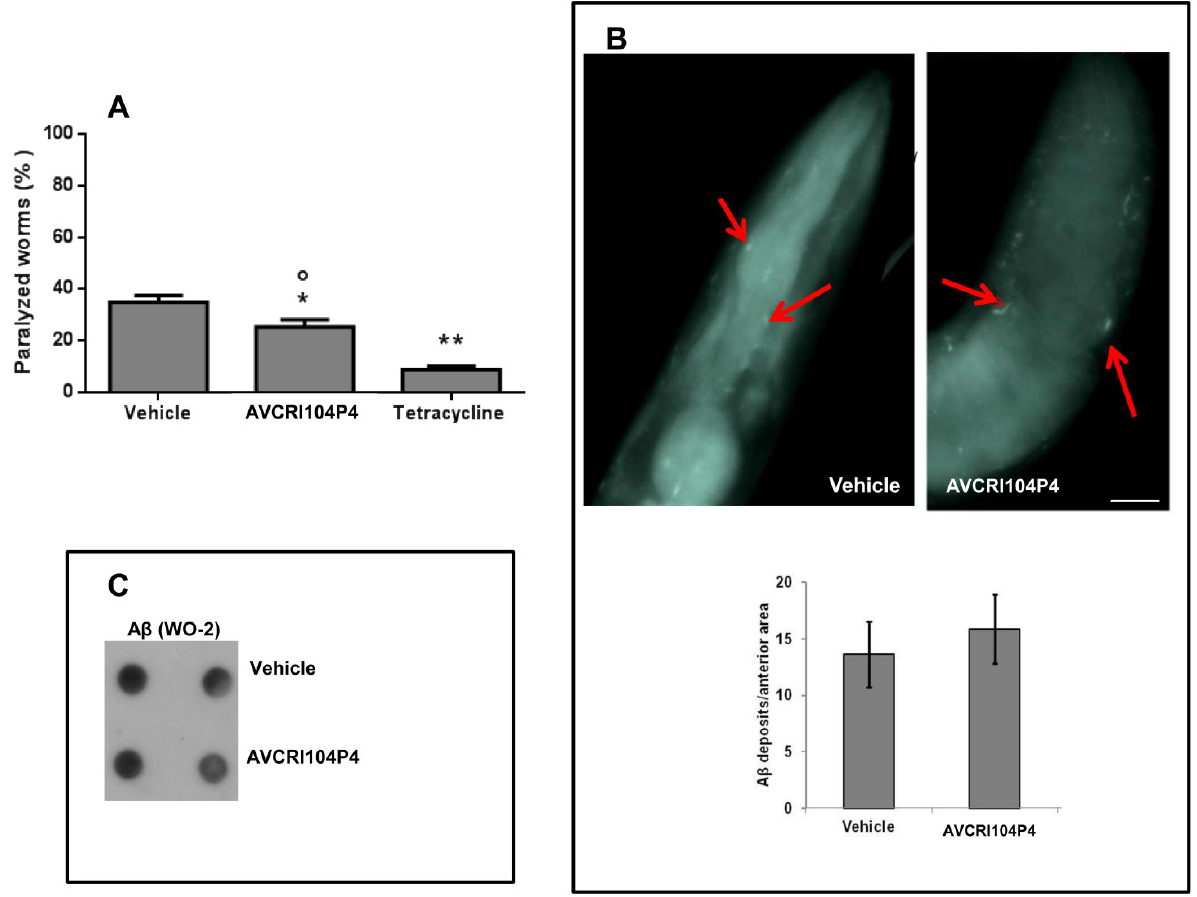
Figure 2. Effect of AVCRI104P4 administration on the paralysis of CL2006 nematodes and Aβ deposition. ( A ) Percentage of CL2006 paralyzed worms treated with AVCRI104P4. Nematodes were treated for 24 h with 100 µM AVCRI104P4 or 100 µM tetracycline (positive control) and the number of nematodes that did not move was scored. Data from three independent experiments ( n = 100, per group) are indicated as % ± S.D. of paralyzed nematodes to worms treated with vehicle. * p < 0.05 and ** <0.01 vs. vehicle-treated CL2006 nematodes and ° p < 0.05 vs. CL2006 worms treated with tetracycline (One-way ANOVA test); ( B ) X-34 positive amyloid deposits in CL2006 worms treated with vehicle or 100 µM AVCRI104P4. Synchronized CL2006 nematodes were treated with vehicle or 100 µM AVCRI104P4 for 24 h, amyloid plaques were stained with X-34 dye and visualized at short wavelength excitation. Scale bar 20 µm. Amyloid deposits in the anterior area of worms, indicated with red arrows, were quantified in nematodes treated with vehicle ( n = 20) or 100 µM AVCRI104P4 ( n = 20), by counting the number of X-34 positive spots; ( C ) Effect of 100 µM AVCRI104P4 administration on total Aβ in CL2006 worms. Representative dot blot of total Aβ (WO2) on lysates (5 µg) of CL2006 transgenic worms treated with vehicle or 100 µM AVCRI104P4 for 24